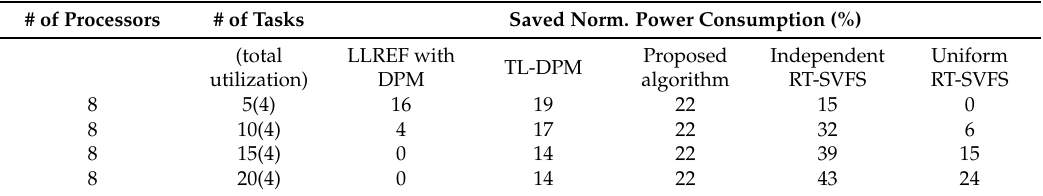
Table 4. Summary of experimental results on varying number of tasks.